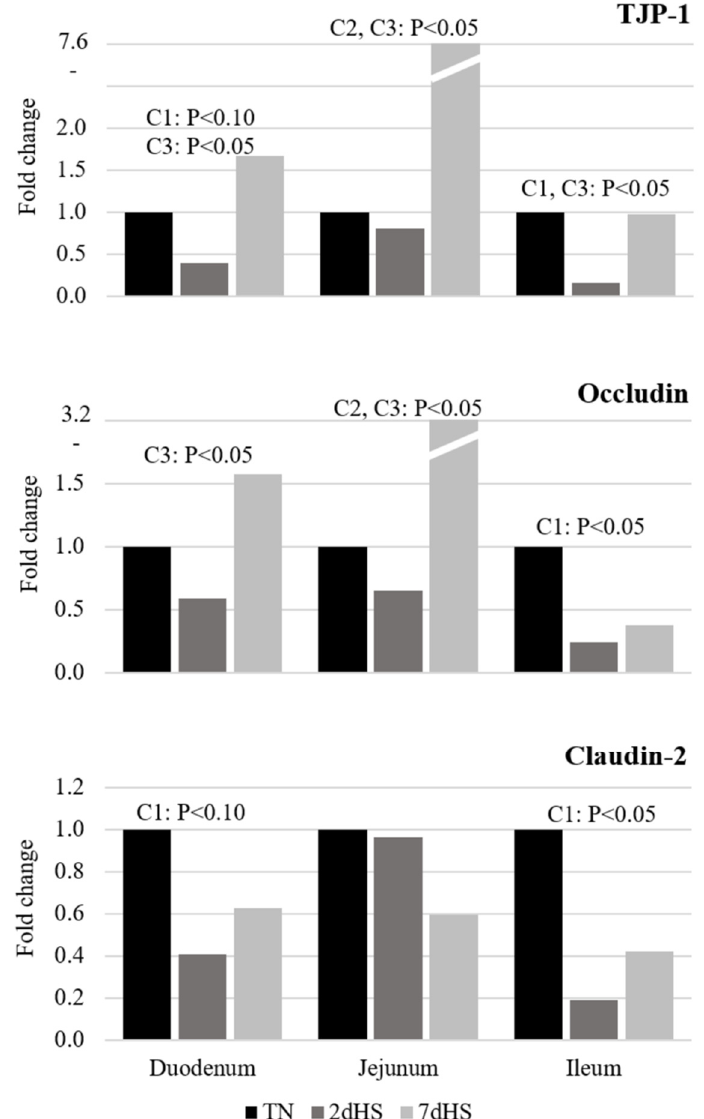
Figure 2. Fold of increase or decrease in expression of Tight Junction Protein 1 (TJP-1), occludin, and claudin-2 in the three sections of small intestine of pigs at d0 in thermoneutral condition (TN); after two d of heat stress (2dHS) or after seven d of heat stress (7dHS). Contrasts: C1, TN vs. 2dHS; C2, TN vs. 7dHS; C3, 2dHS vs. 7dHS.